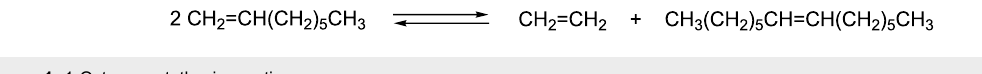
Scheme 1: 1-Octene metathesis reaction.